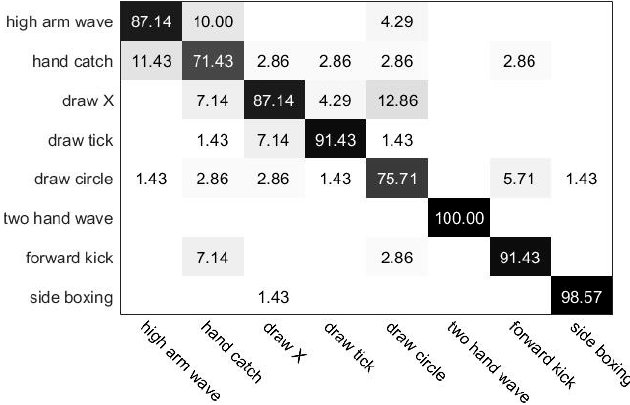
Figure 4. Confusion matrix of our proposed method in AS2.